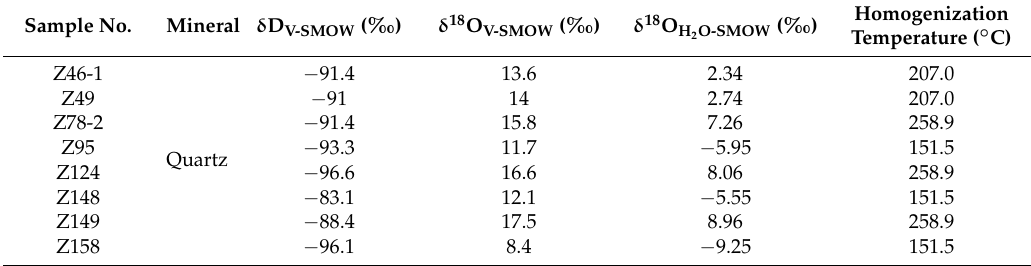
Table 8. H and O isotope data of quartz from the Xiajinbao gold deposit.